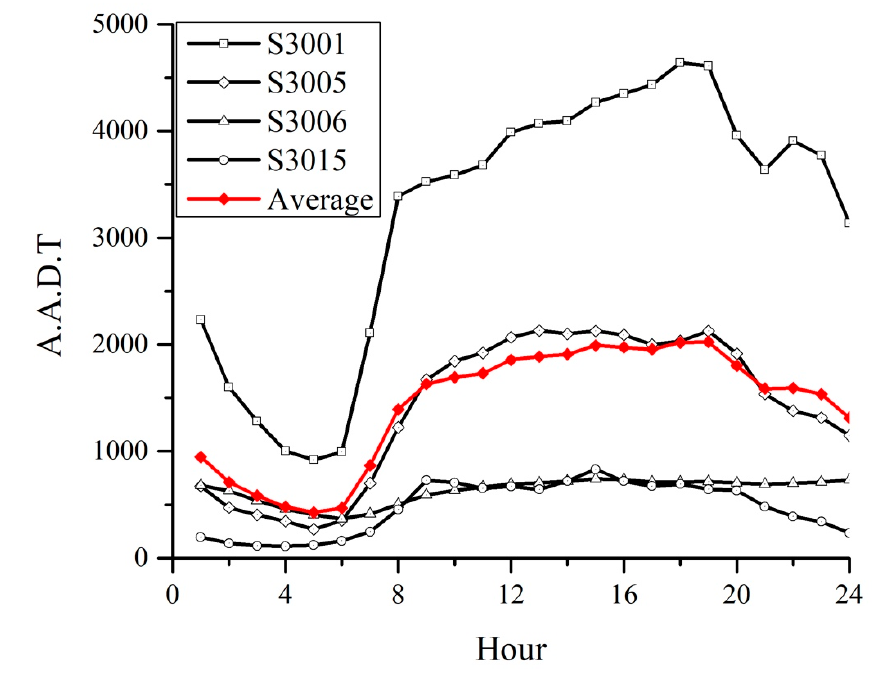
Figure A2. Hourly vehicle traffic at each station. Table A2. Annual Average Daily Traffic (A.A.D.T) at selected monitoring stations. Location of the